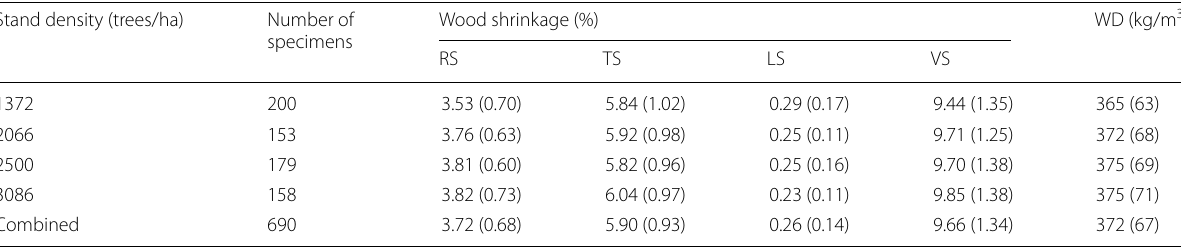
RS radial shrinkage, TS tangential shrinkage, LS longitudinal shrinkage, VS volumetric shrinkage, WD basic wood density Values in the parentheses are the standard deviations